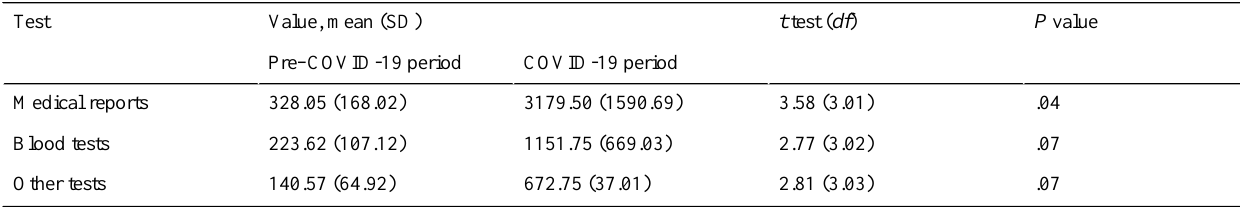
Table 4. Average number of monthly tests, classified by type.